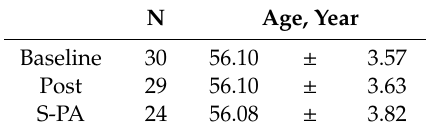
Table 1. Mean ages of the participant groups.